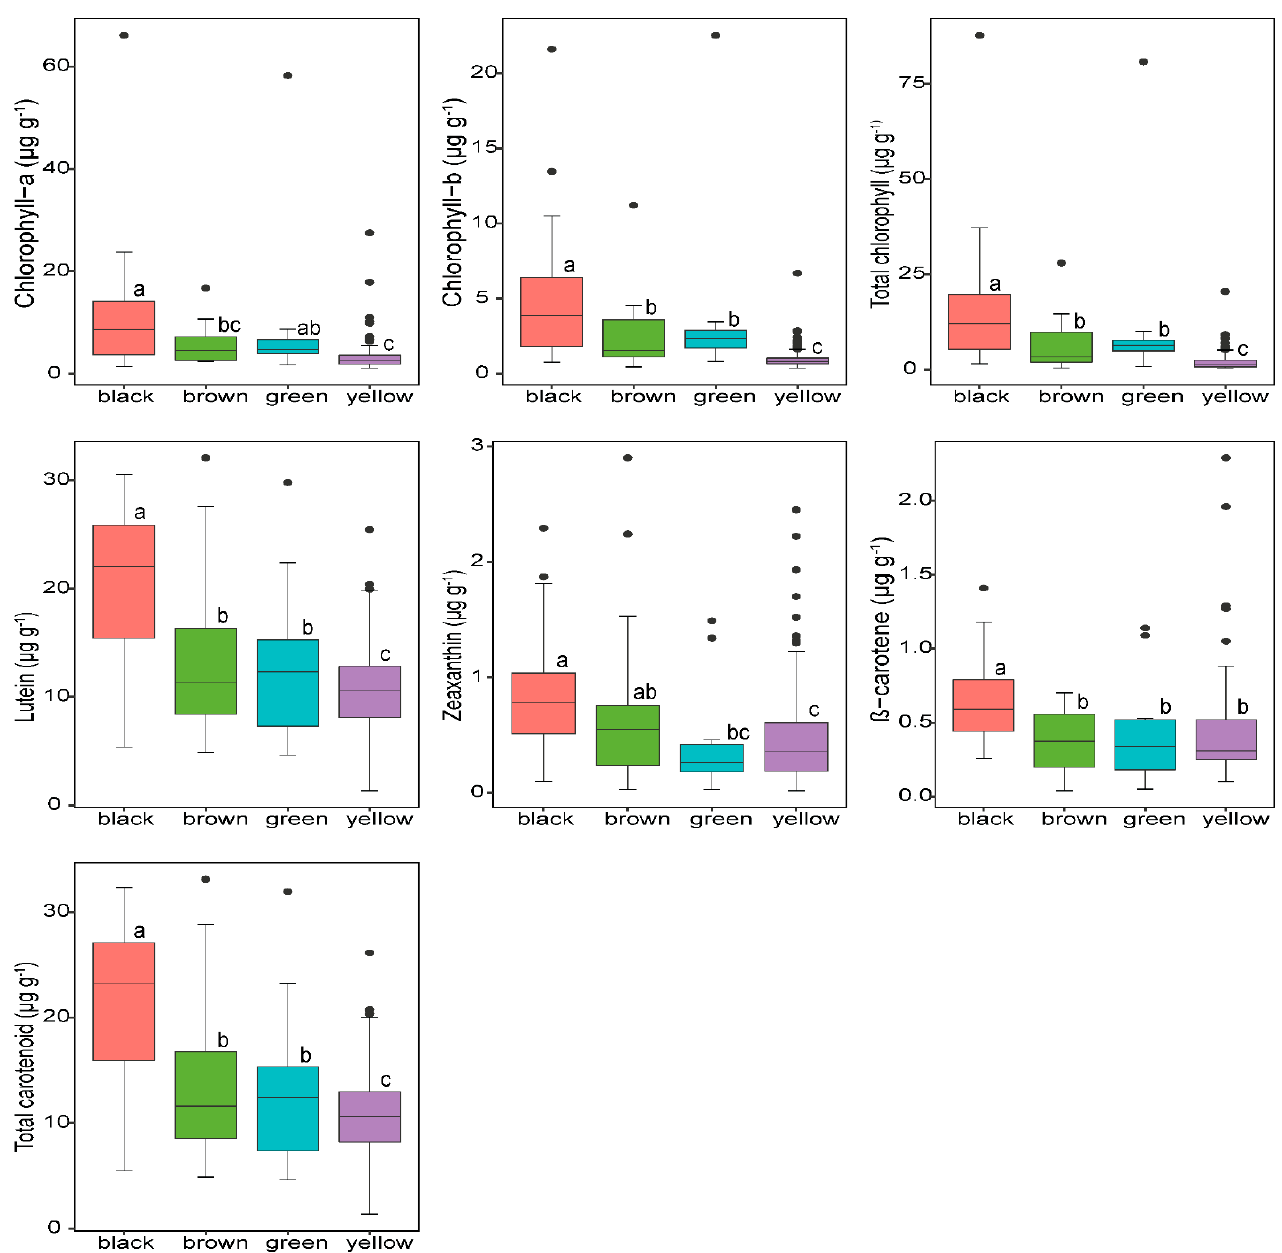
Figure 2. Seed carotenoid and chlorophyll concentrations of soybean accessions with different seed coat colors: black ( n = 41), brown ( n = 18), green ( n = 18) and yellow ( n = 331). n represents sample size. Different lower-case letters (a, b, c) indicate statistically significant difference at p < 0.001 level among the seed coat colors.